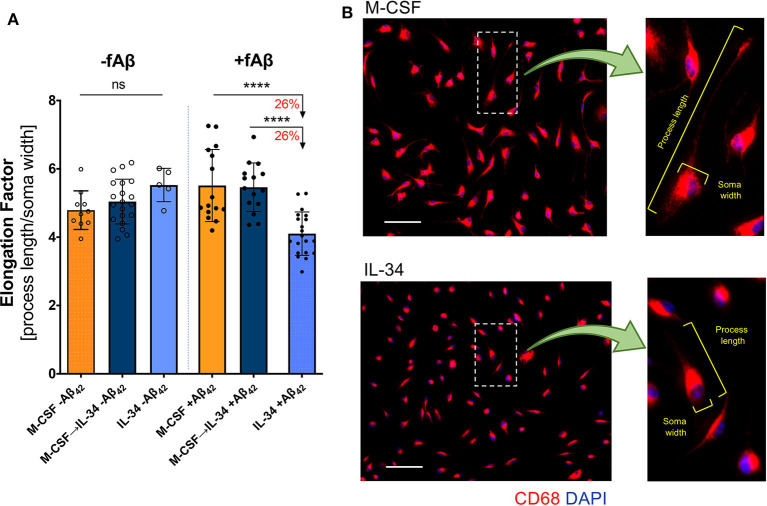
IL-34 treatment reduces macrophage elongation in response to fibrillar Aβ42. (A) Quantitative ICC analyses assessing macrophage elongation with and without exposure to fibrillar (f)Aβ42. An elongation factor was calculated based on the ratio of cell-process length to soma width. (B) Representative images of CD68+ macrophage morphology in response to fAβ42. The insets provide an example of elongation factor measurements in both treatment groups. Scale bars: 50 μm. ****P < 0.0001 and ns = not significant, by one-way ANOVA with Tukey's post-test.